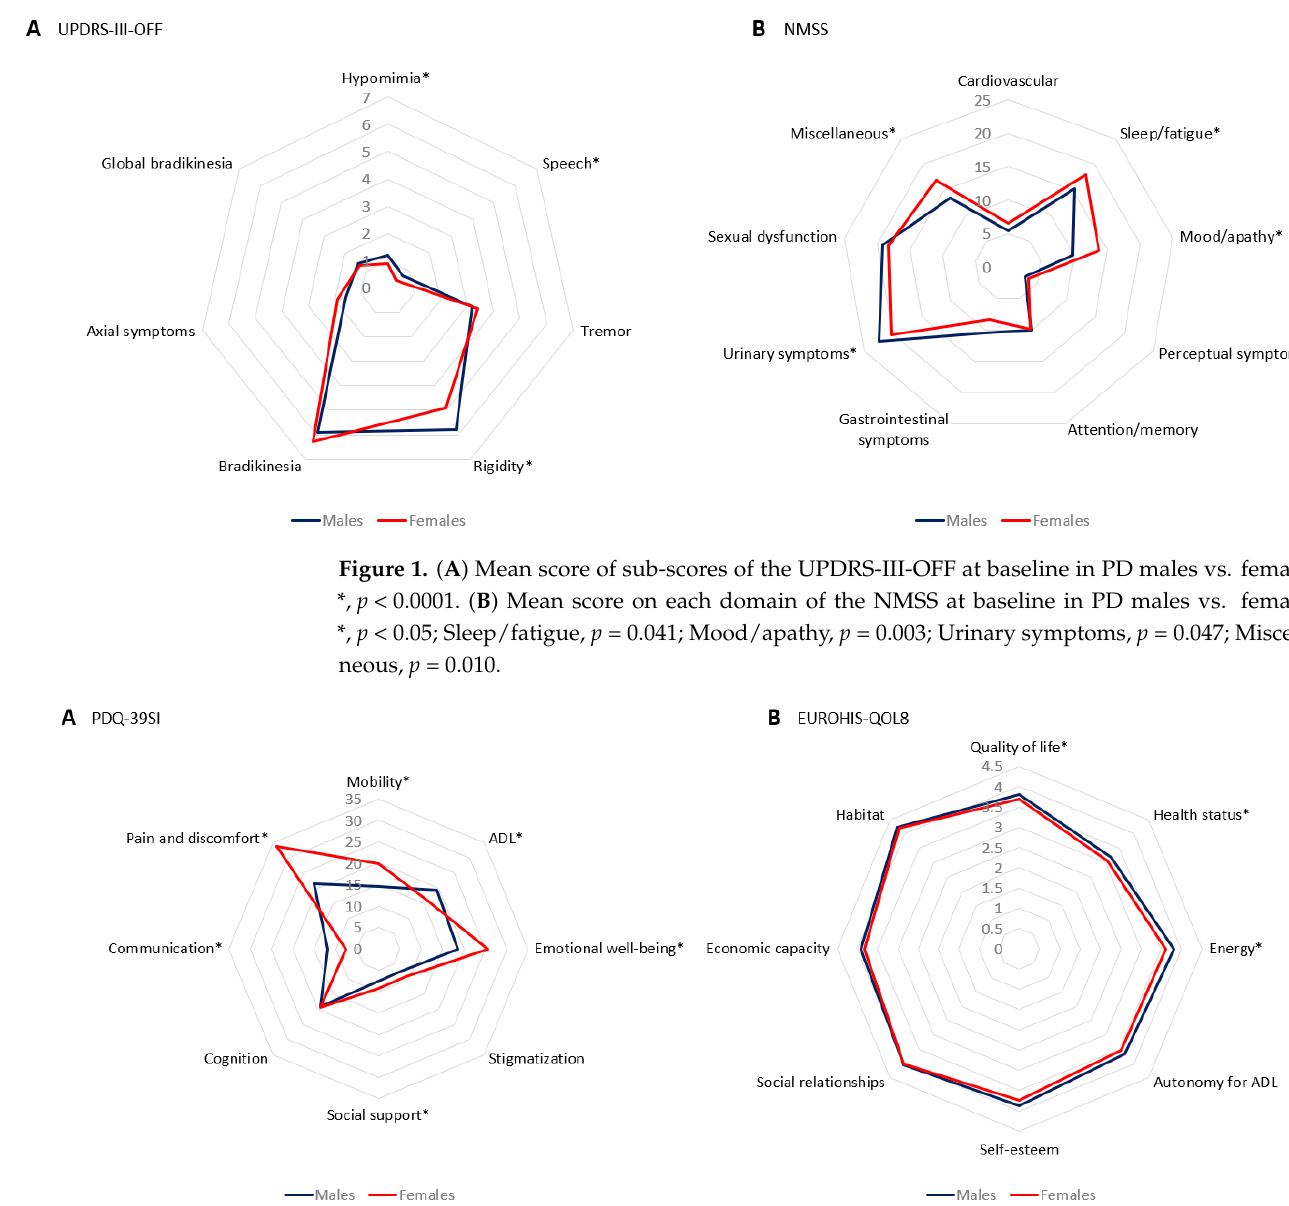
Figure 2. ( A ) Mean score of each domain of the PDQ-39 at baseline in PD males vs. females; *, p < 0.05; Mobility, p = 0.01; ADL, Activities of daily living, p = 0.034; Emotional well-being, p < 0.0001; Social support, p = 0.046; Communication, p < 0.0001; Pain and discomfort, p < 0.0001. ADL: Activities of daily living (ADL): ( B ) Mean score on each domain of the EUROHIS-QOL8 at baseline in PD males vs. females; *, p < 0.05; Quality of life, p = 0.014; Health status, p = 0.020; Energy, p = 0.04.